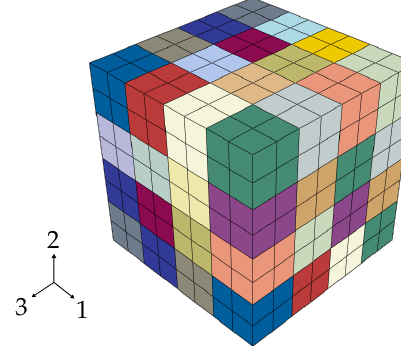
Figure 8. RVE variant V2 with 512 elements for the simulation of effective cyclic properties.